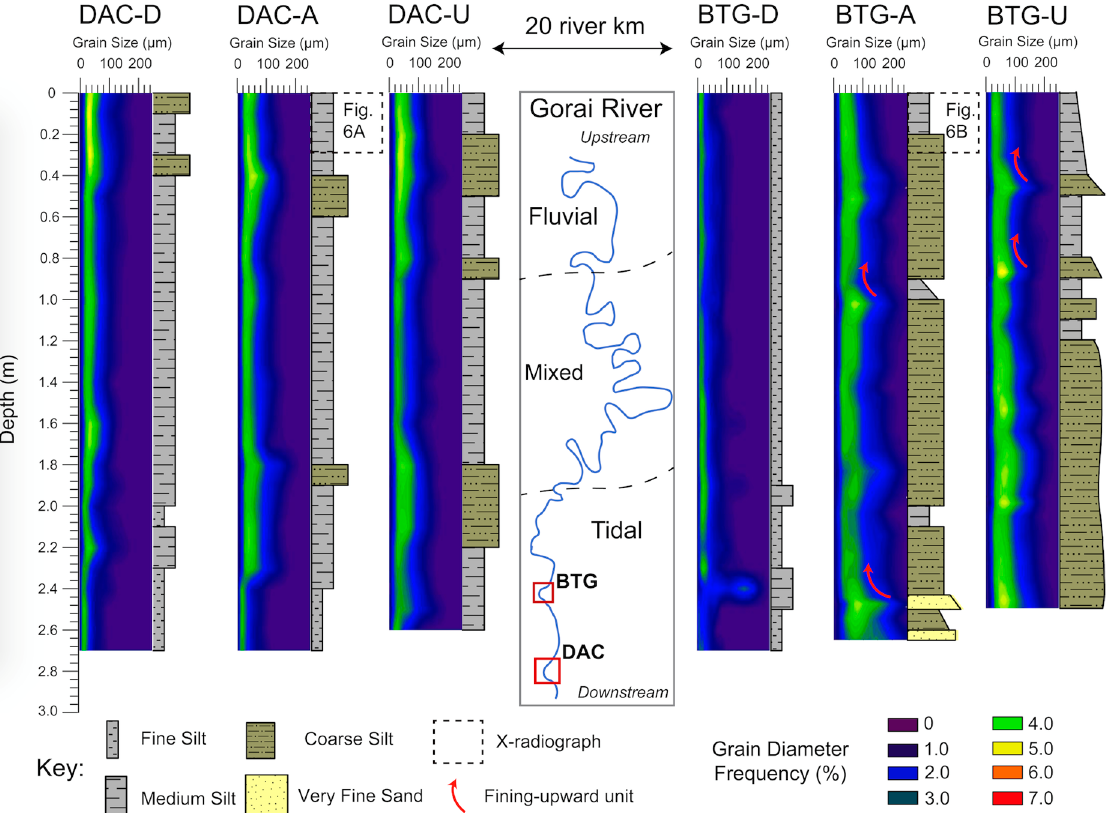
Figure 5. Core stratigraphy at Dacope (DAC) and Batiaghata (BTG) sites, located within the tidal depositional zone (mean tide range at DAC and BTG are 2.8 m and 2.4 m, respectively). Down-core trends in grain size are represented by two panels for each core: volumetric frequency distributions between 0 and 250 µm ( left ), and median grain size ( right ).